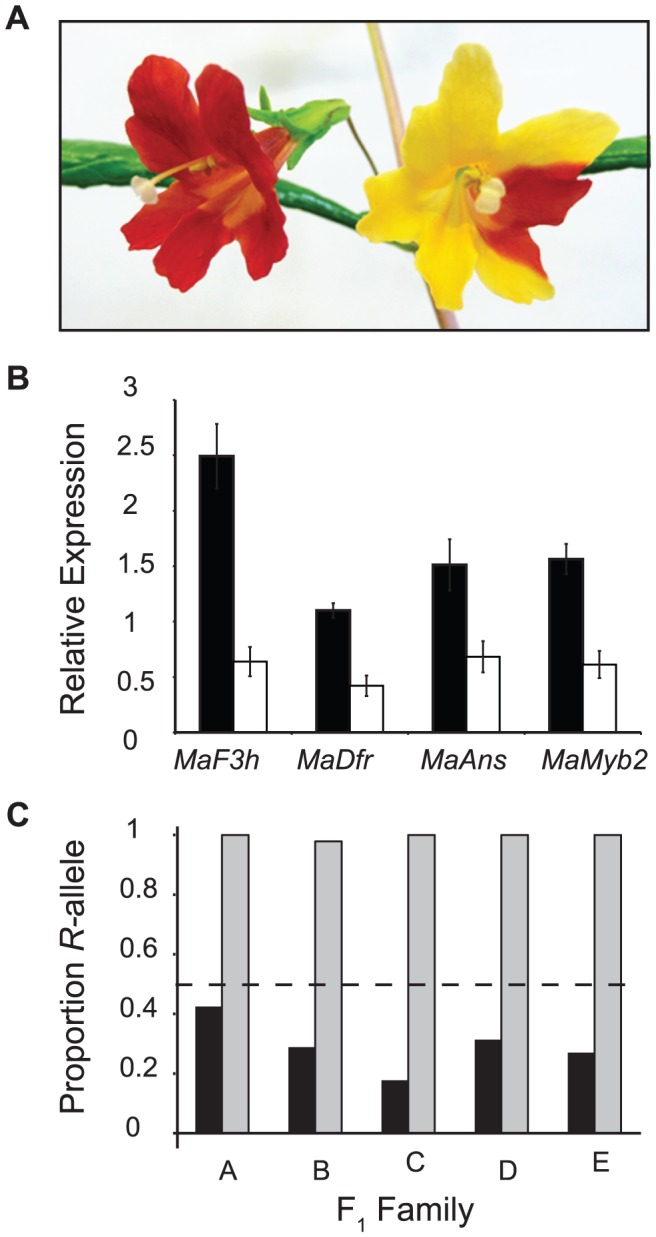
A cis-regulatory mutation in MaMyb2 alters anthocyanin enzyme expression and flower color.
(A) Wild-type (left) and MaMyb2-silenced (right) flowers from VIGS experiments. See Figure S1 for additional pictures demonstrating the range of silencing. (B) Compared to pTRV2 negative controls (black bars), MaMyb2 VIGS silencing (white bars) leads to significantly fewer floral transcripts of MaMyb2 and the enzymes it regulates (FMaF3h
 (1, 10) = 46.07, P<0.0001; FMaDfr
(1, 10) = 23.38, P = 0.0007; FMaAns
(1, 10) = 10.41, P = 0.009; FMaMyb2
(1, 10) = 22.72, P = 0.0008). Error bars are one standard error. (C) Among five independent F1 crosses, the R-allele at MaMyb2 is represented in floral cDNA at significantly higher levels than the Y-allele [cDNA (grey bars) compared to gDNA (black bars), Fisher's exact test: P<10−9 in all families; cDNA compared to equal contribution of both alleles (dashed line), Fisher's exact test: P<10−4 in all families]. This indicates that a cis-regulatory mutation in MaMyb2 accounts for the signficant differences in MaMyb2 floral expression.